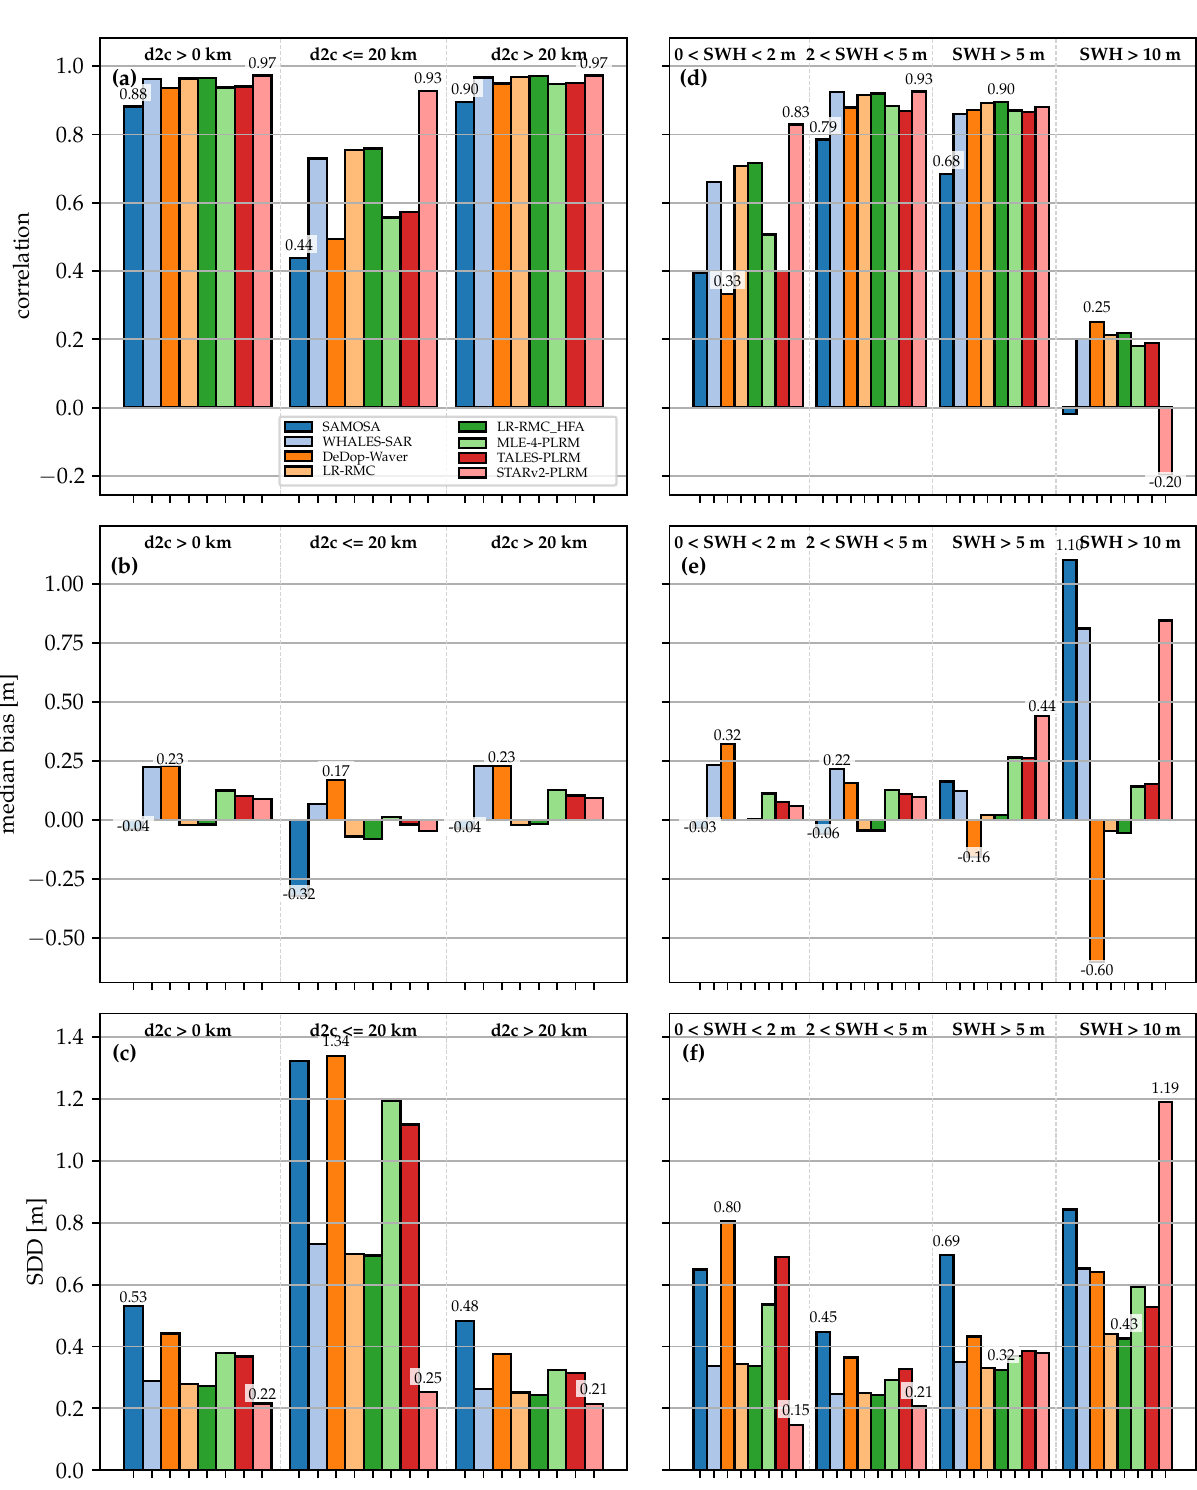
Figure 10. Comparison of the ( a,d ) correlation coefficient, ( b,e ) median bias, ( c,f ) SDD against ERA5-h model of the individual S3A retrackers as a function of dist2coast and of SWH,